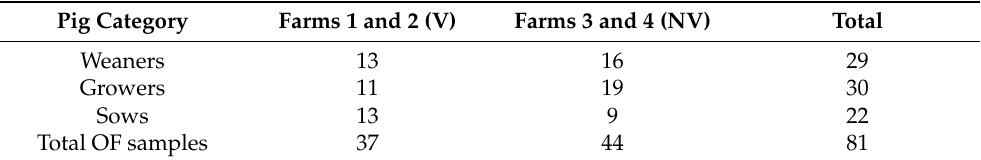
Table 1. Number of oral fluid (OF) samples examined from vaccinated (V) and non-vaccinated (NV) pigs of three pig